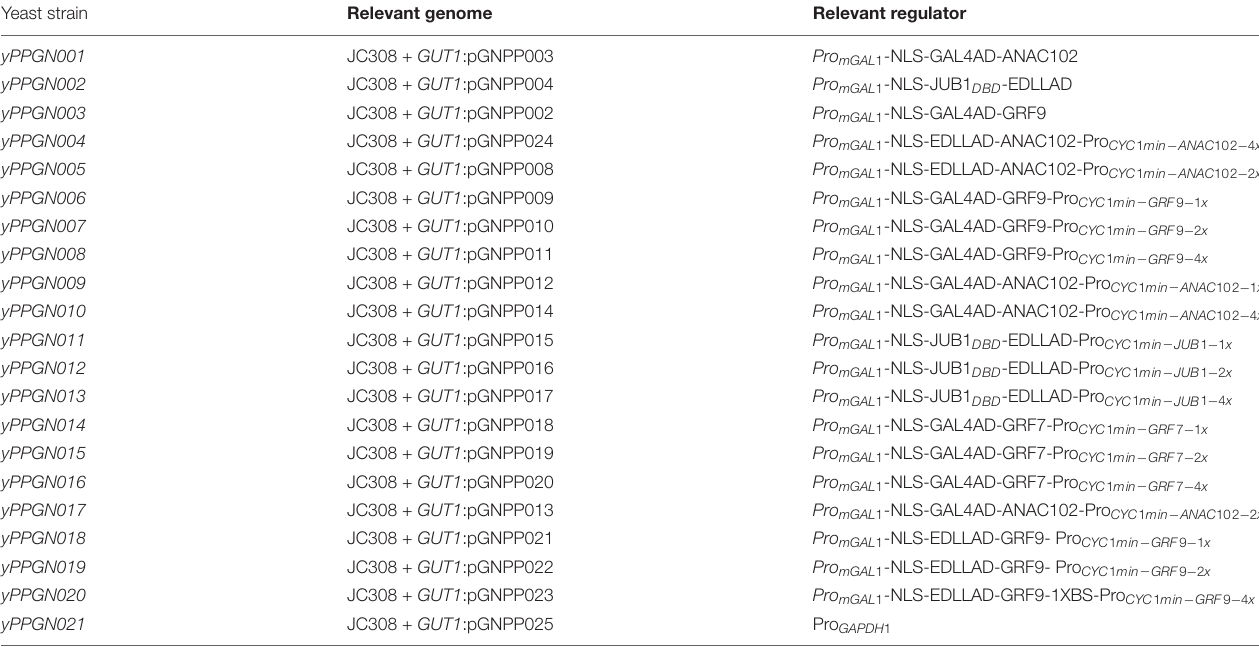
TABLE 1 | List of P. pastoris strains for characterization of plant-derived ATF/BSs generated in JC308 background (Lin Cereghinoa et al., 2001). Yeast strain Relevant genome Relevant